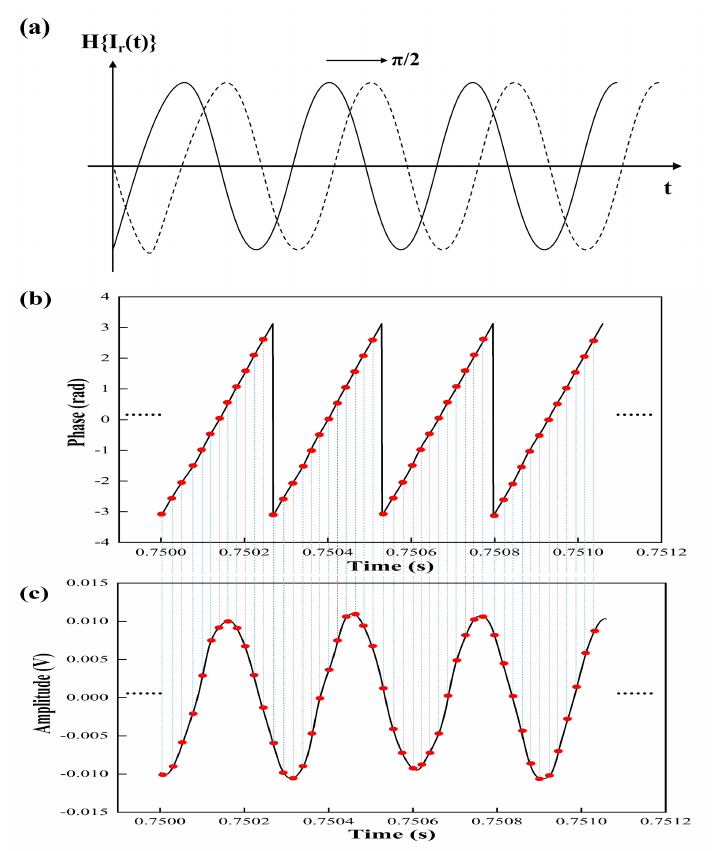
Figure 4. Schematic diagram of HT and resampled signal, ( a ) the beat signal shifting π /2 phase by HT, ( b ) the subdivision phase of beat signal, ( c ) resampled point of beat signal of measurement optical